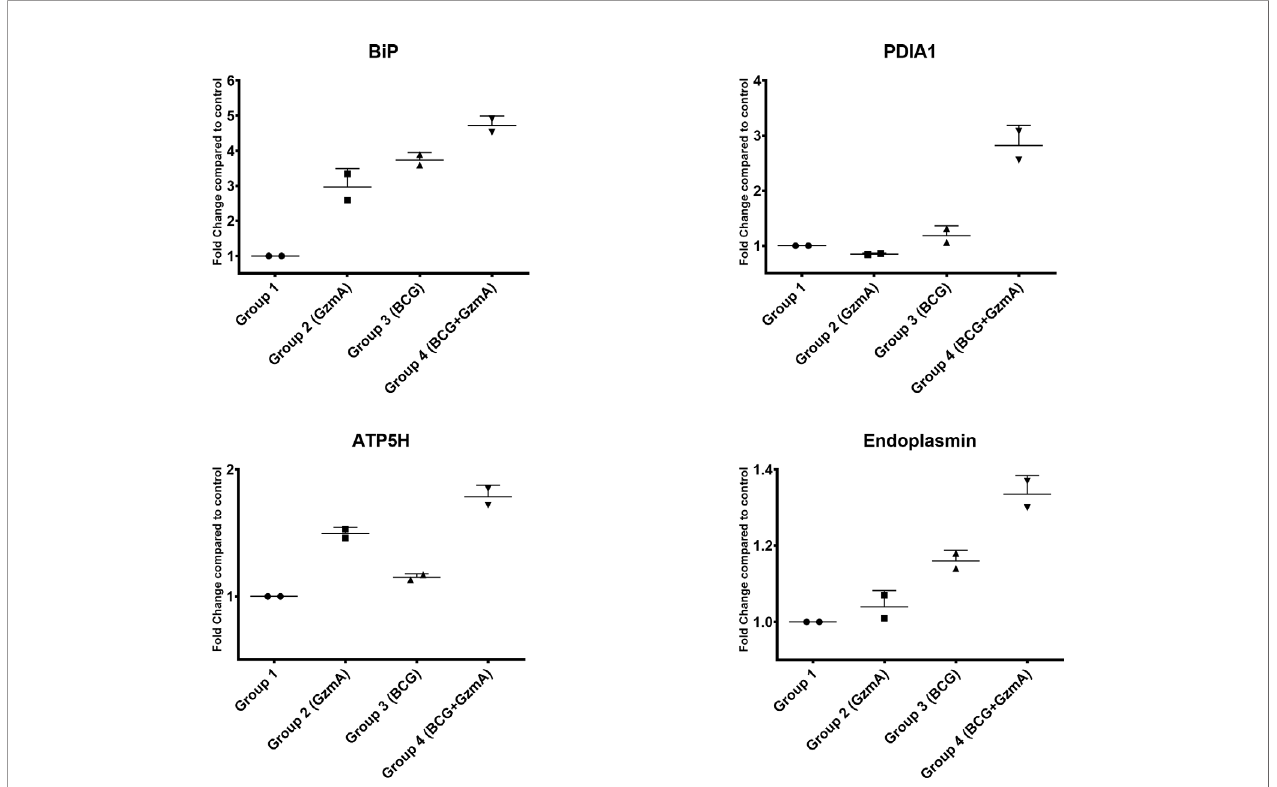
FIGURE 4 | ER stress response and ATP producing proteins are involved in GzmA-mediated mycobacterial control. Graphs show four proteins that were selected from Table 1 . Using Odyssey CLx near-infrared platform and total protein for normalization, data con fi rms 2D-DIGE results. Protein lysate obtained from 2 additional subjects that were not included in original 2D-DIGE analysis. Experiments done in triplicates per group, means ±